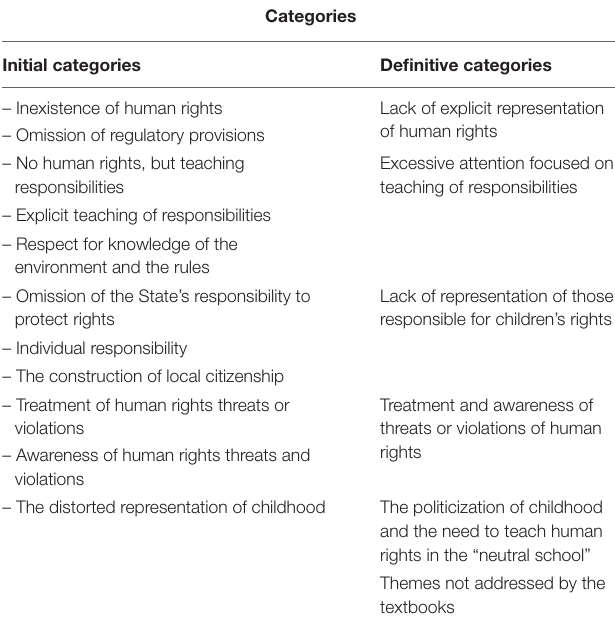
TABLE 1 | Categories from the qualitative